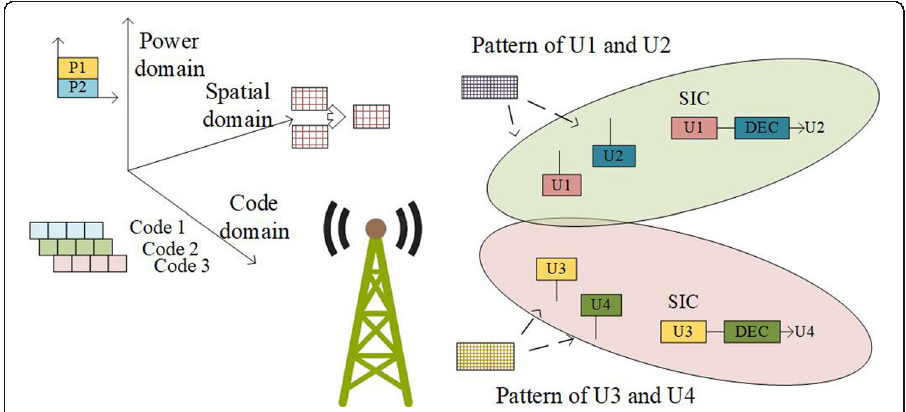
Fig. 1 PDMA downlink technology framework. The process of PDMA downlink transmission